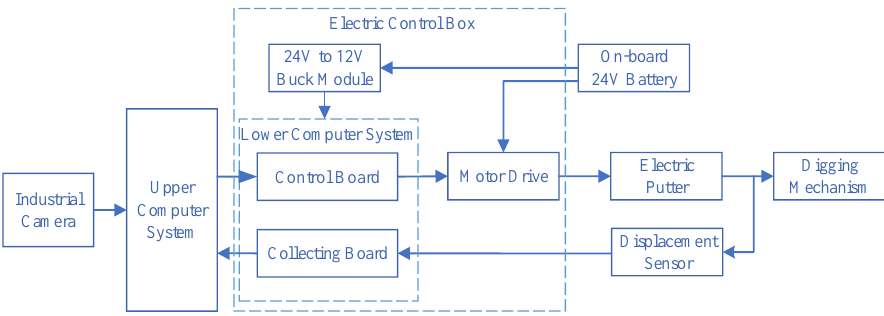
Figure 1. Automatic depth limiting structure diagram.